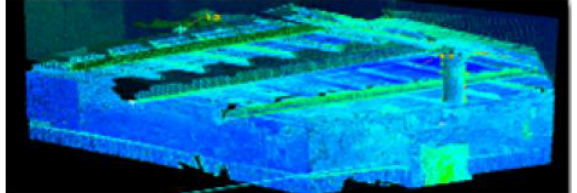
Figure 10. Image 10 represent a tool in Cyclone used for identification of significant architectural elements defining specific section